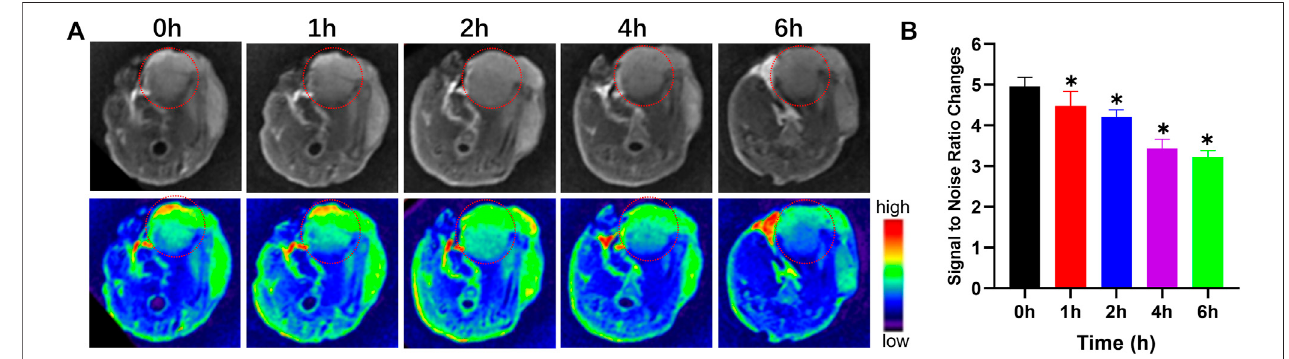
FIGURE5| T2-weightedMRimages (A) andchangesinthesignal-to-noiseratio (B) priortoandfollowingtheinjectionofaFe 3 O 4 @PDAnanocompositesolutionin orthotopic tumor-bearing